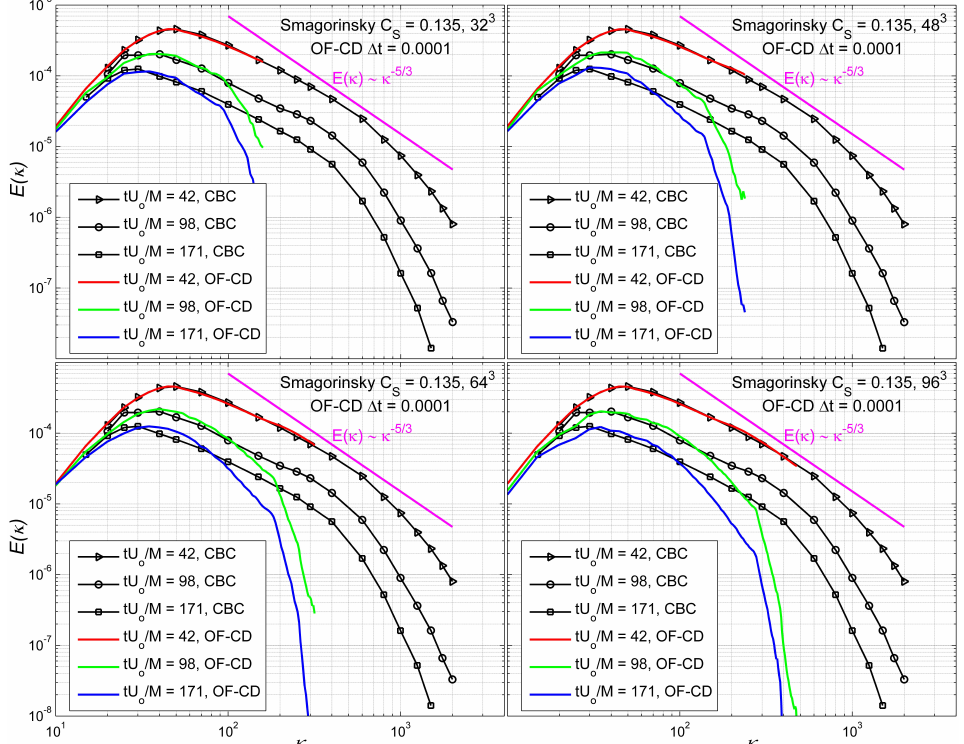
Figure 10. Spectra obtained with the OpenFOAM approach and C S = 0.135 on 32 3 , 48 3 , 64 3 and 96 3 grids (clockwise from ( top-left